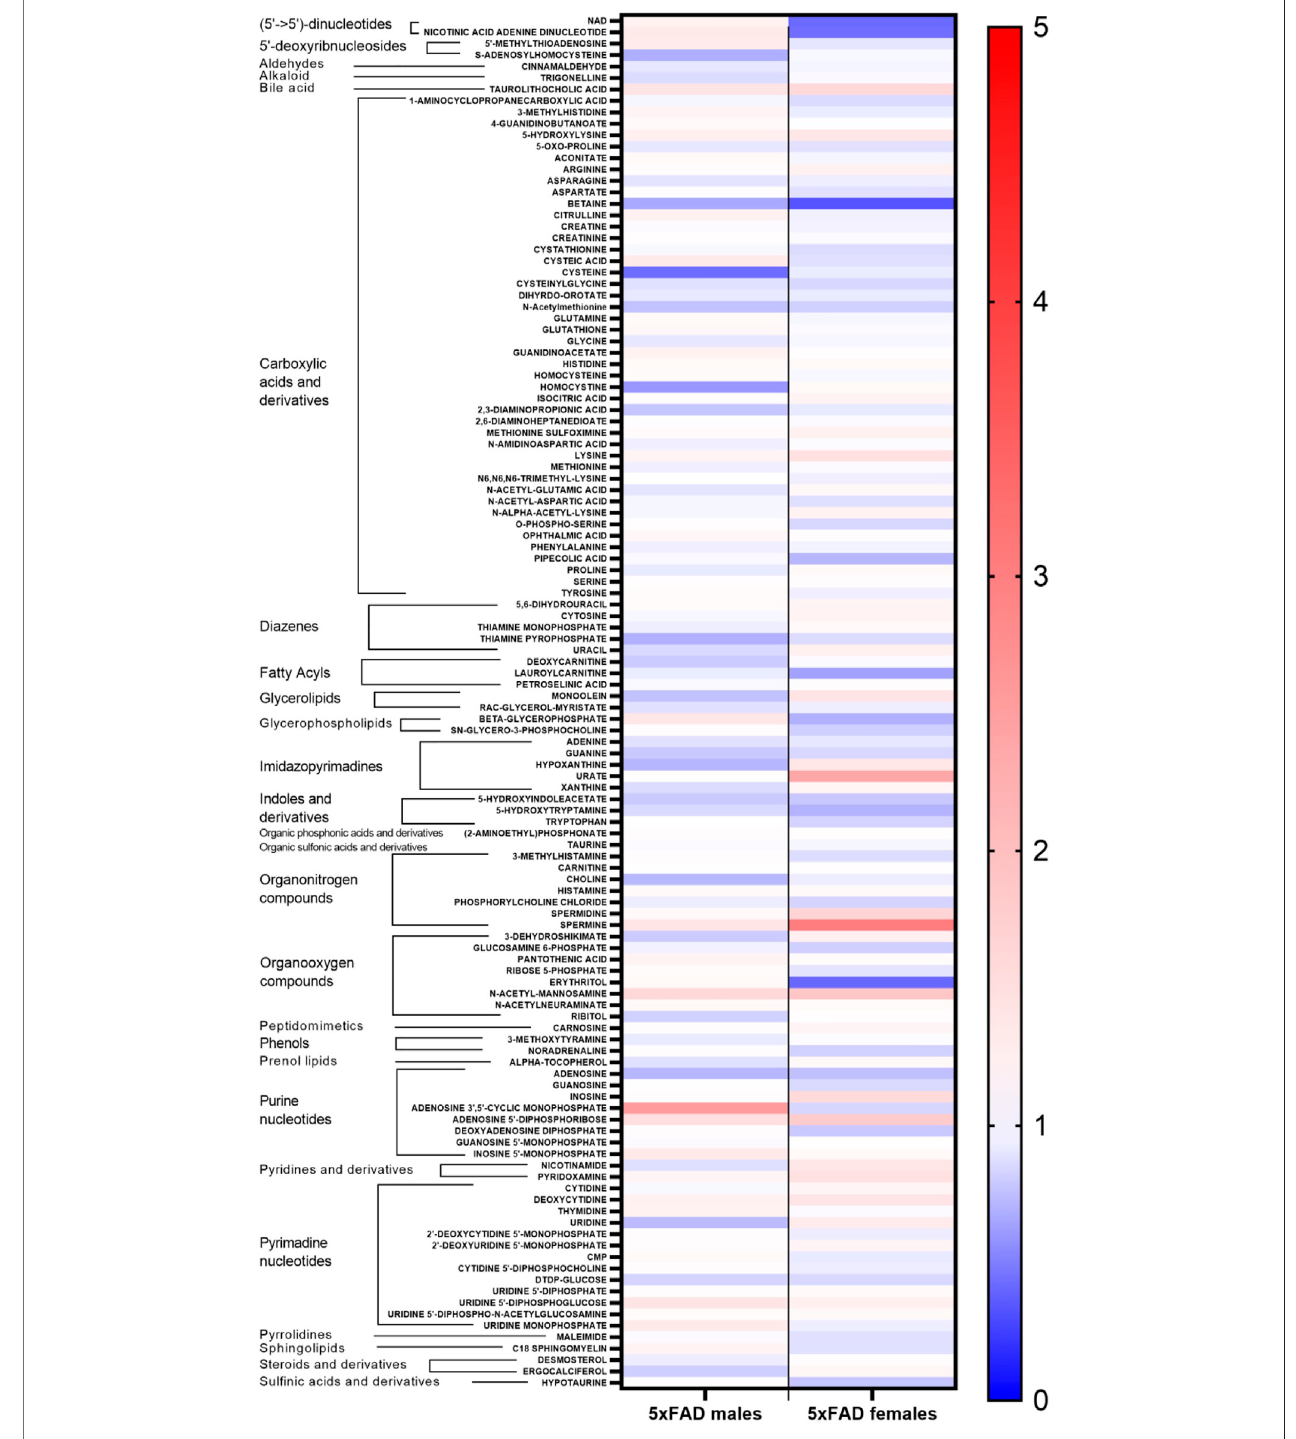
FIGURE 2 | Heatmap of changes in identi fi ed metabolites in male and female 5xFAD mice compared to male and female wild-type (WT) mice, respectively.